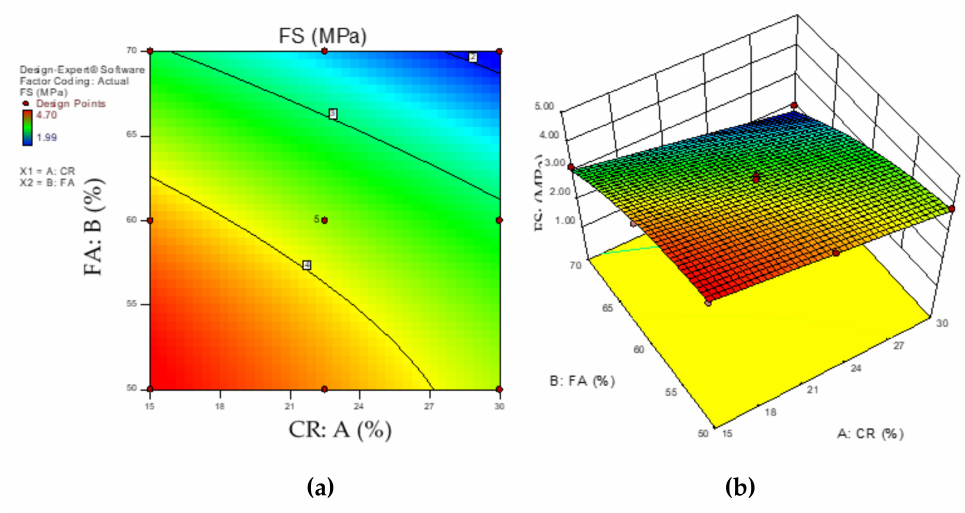
Figure 12. HVFA–CRC 2D and 3D response surface diagrams for FS.